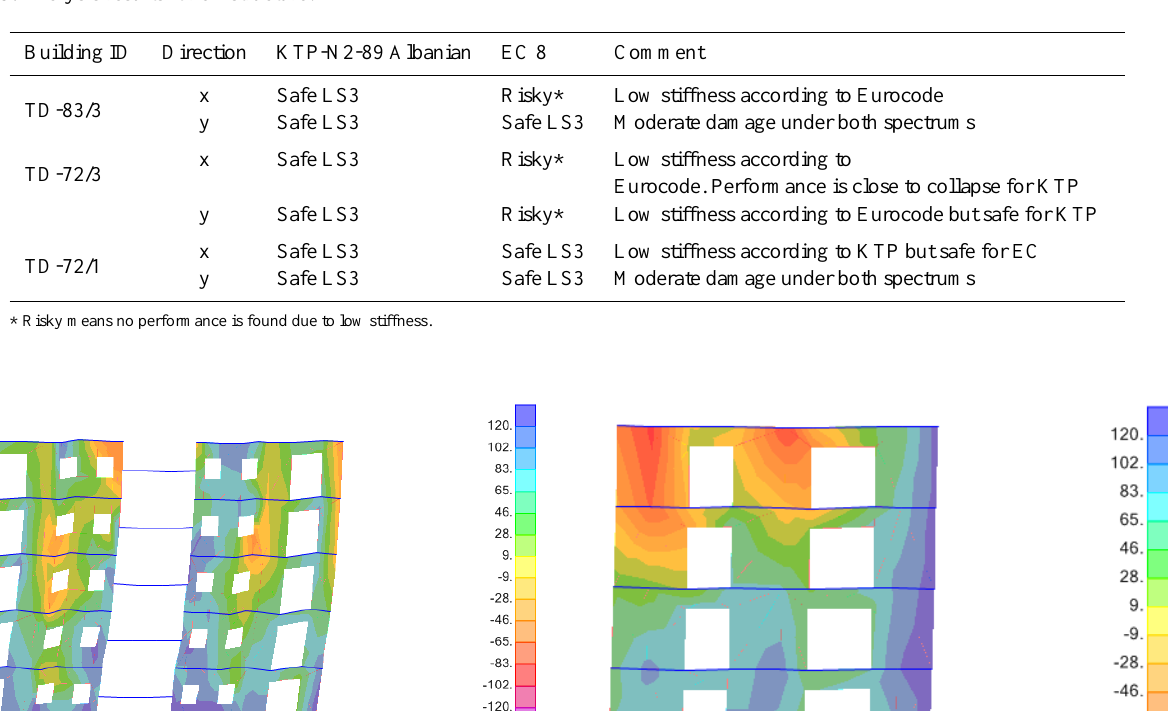
Table 5. Analysis results for all structure.